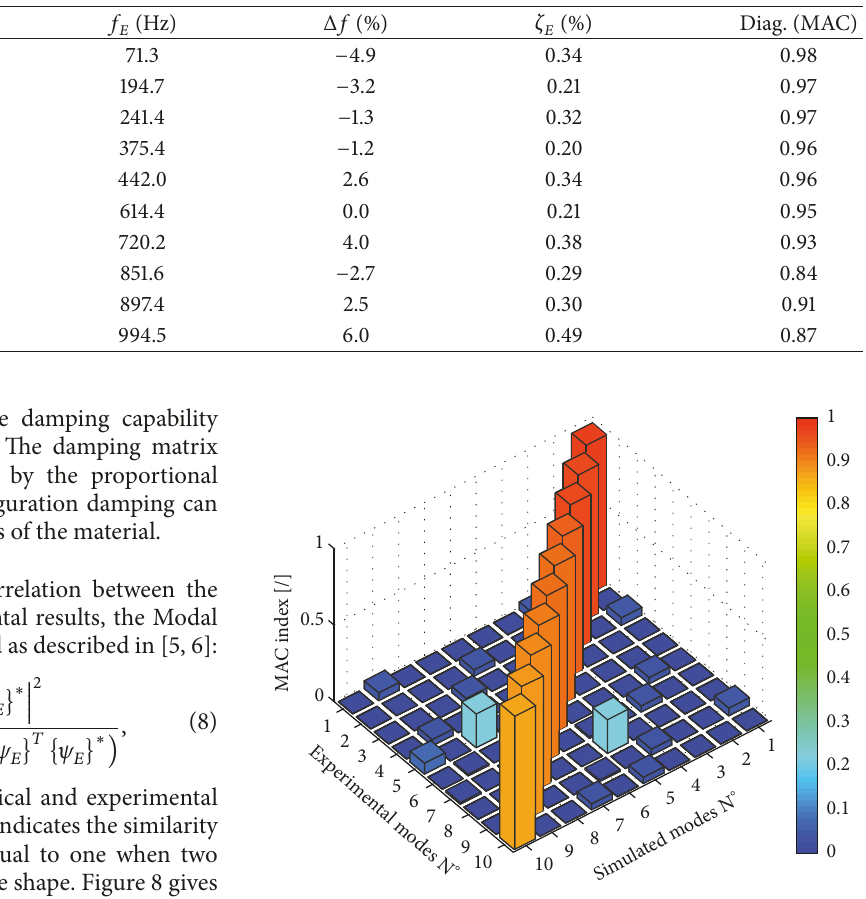
Table 2: Natural frequencies, damping ratios, and MAC values for the leaf spring.